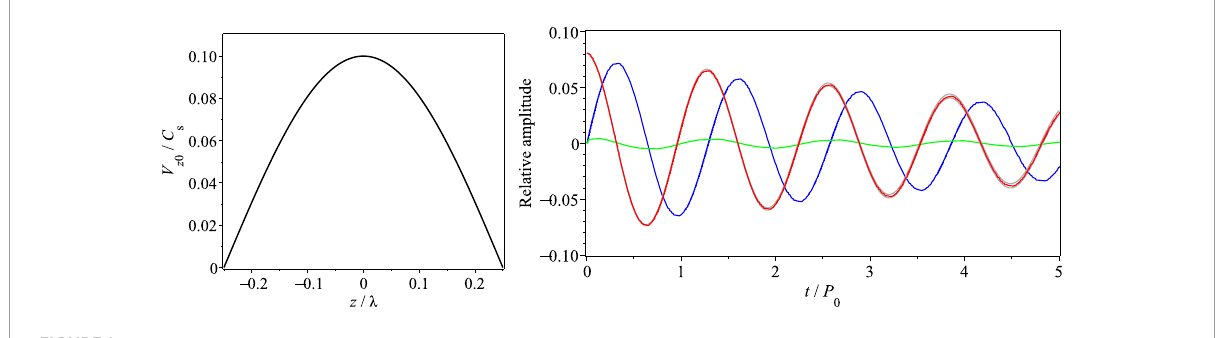
FIGURE 1 Left: The form of the initial perturbation of the plasma velocity, V z 0 = 0 . 1 C s cos ( 2 π z / λ ) , applied to the loop model described in Section 2 . Right: Variations of the slow wave-perturbed plasma velocity, density, and temperature in red, blue, and green, measured at z = 0 . 1 λ and for κ ‖ = 10 κ Sp , normalised to C s , ρ 0 , and T 0 , respectively. C s = √ γ k B T 0 / m is the adiabatic sound speed; λ is the wavelength (prescribed by the loop length, L , as λ = 2 L ); P 0 is the adiabatic acoustic oscillation period, 2 L / C s . The grey lines illustrate the numerical error estimate for the velocity